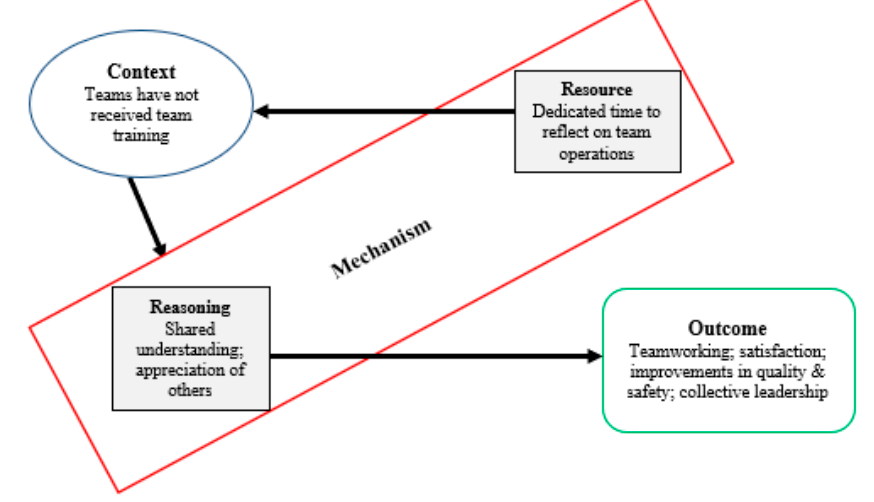
Figure 2. Explanatory programme theory of the how Co-Lead intervention operates [23].